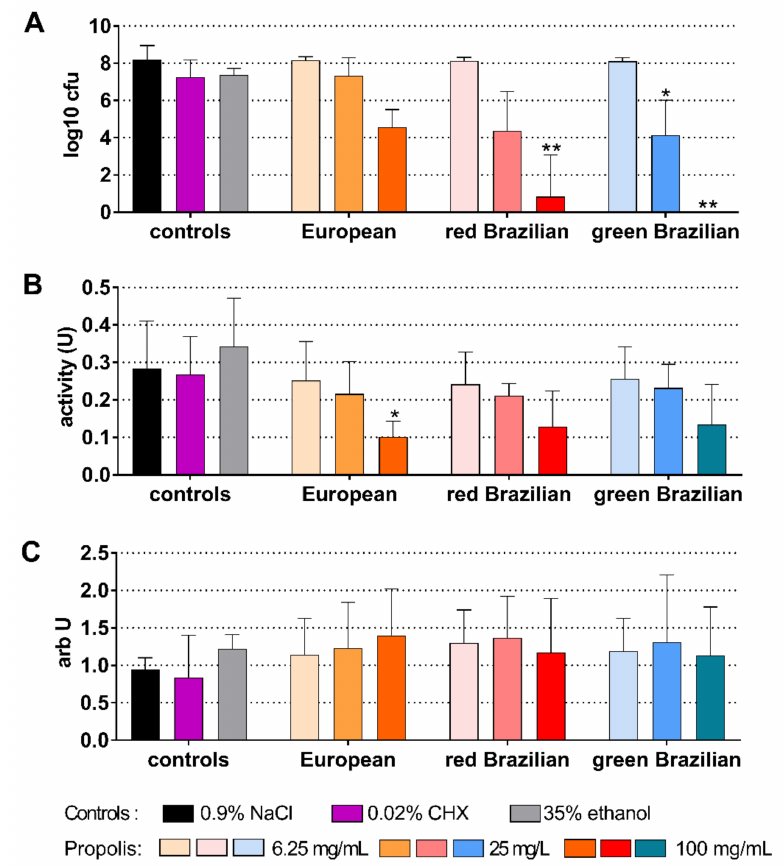
Figure 6. Activity of the different ethanolic extracts of propolis (European and red and green Brazilian) on colony forming units (cfu) ( A ), metabolic activity ( B ), and quantity ( C ) on a 5-day-old periodontal biofilm. */** p < 0.05/ p < 0.01 vs. control 0.9%